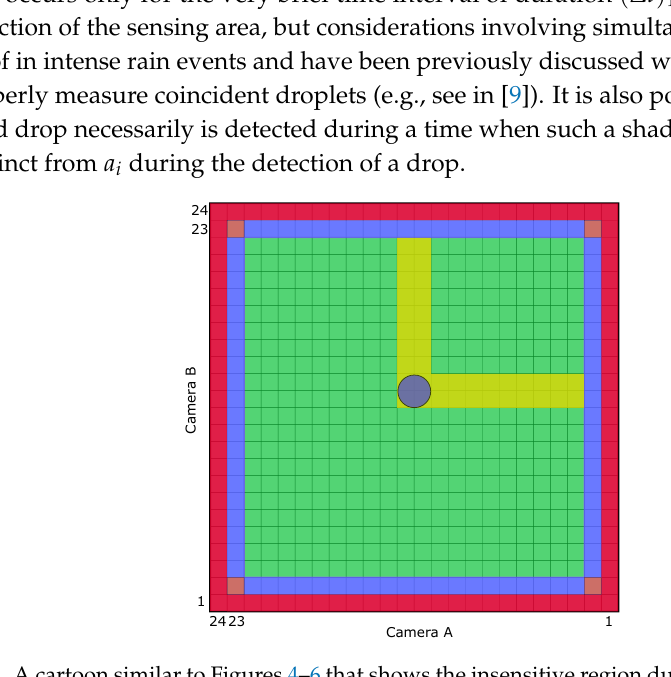
Figure A2. A cartoon similar to Figures 4–6 that shows the insensitive region during a drop detection in yellow; this “shadow area” prevents the simultaneous detection of a drop anywhere in the highlighted region. The yellow highlighted area is what is referred to as δ i in the